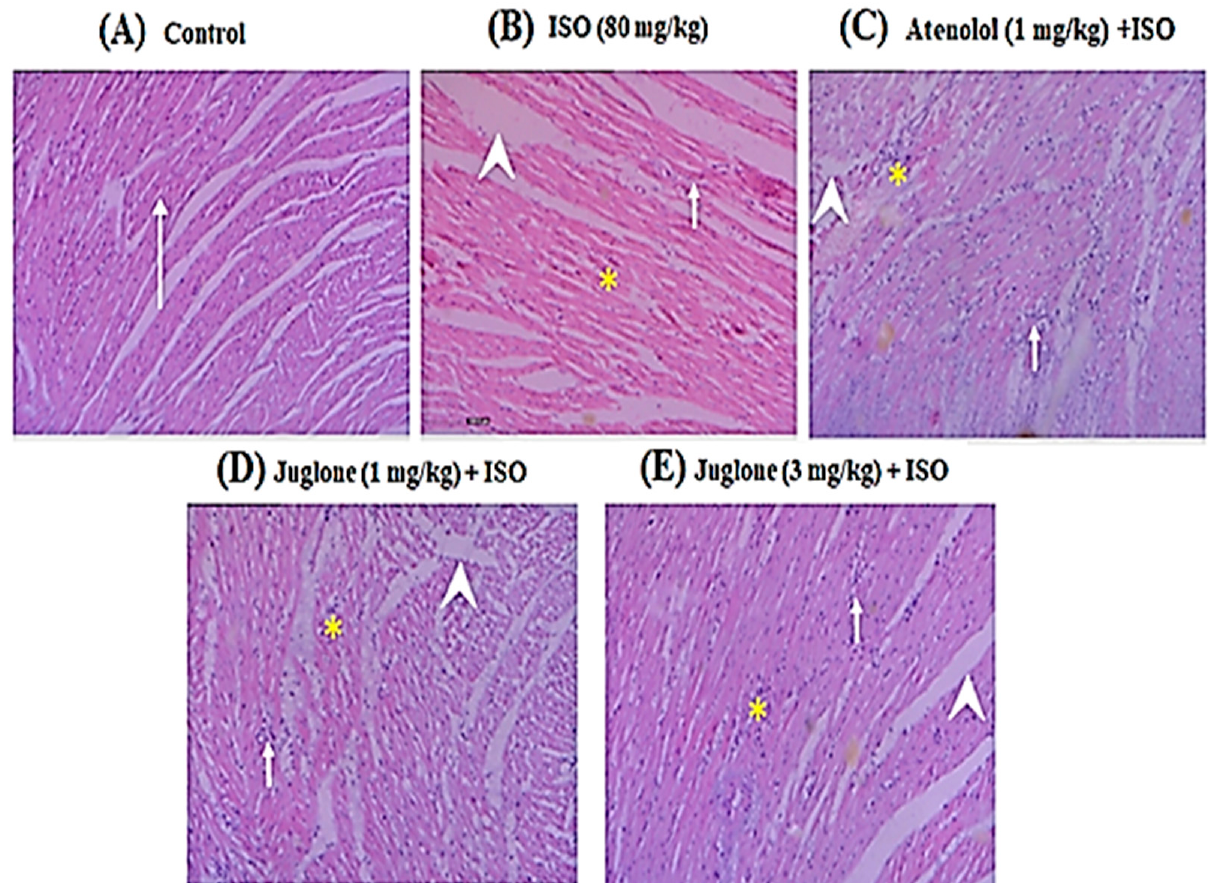
Figure 6. Heart tissue (H&E, 200×) of ( A ) control, shows normal cardiomyocytes (arrow), ( B ) isoproterenol (ISO)-alone treated shows marked inflammation (arrow), edema (arrow head) and confluent necrosis (asterisk), ( C ) pretreatment with atenolol + ISO produced moderate reduction in inflammation (arrow), edema (arrow head) and necrosis (asterisk), ( D ) 1 mg/kg juglone + ISO produced moderate reduction in inflammation (arrow), edema (arrow head) and necrosis (asterisk) and ( E ) 3 mg/kg juglone + ISO produced maximal reduction in inflammation (arrow), edema (arrow head), and necrosis (asterisk), respectively. Table 1. Preventive effects of juglone and atenolol on the degree of histological changes in myocardium of isoproterenol (ISO)-administered ischemic rats.